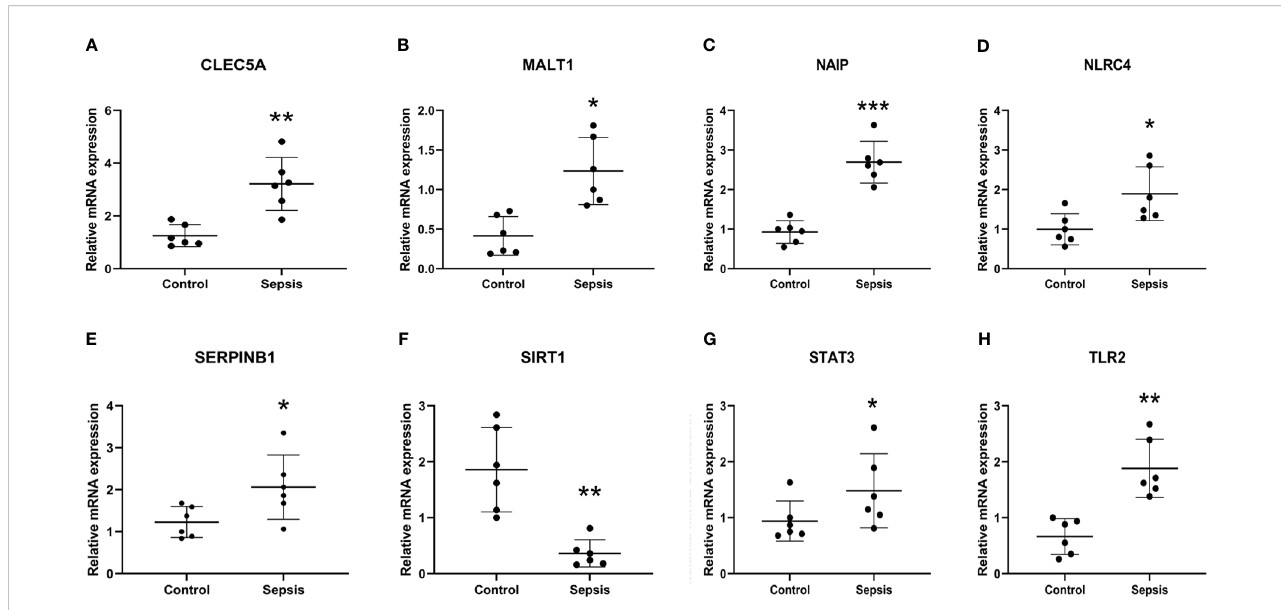
FIGURE 9 Transcriptional expression in whole blood from sepsis patients and healthy controls of CLEC5A (A) , MALT1 (B) , NAIP (C) NLRC4 (D) , SERPINB1 (E) , SIRT1 (F) , STAT3 (G) and TLR2 (H) relative to GAPDH. Mean ± standard deviation, *** P <0.001, ** P <0.01, * P <0.05 vs. the Control